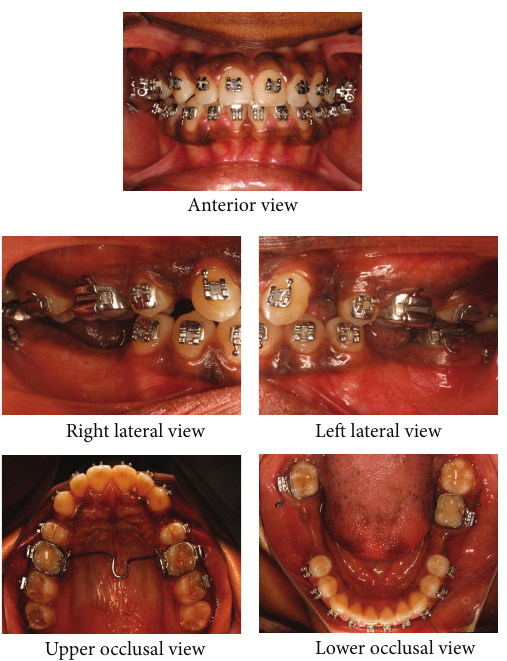
Figure 3: Mid-treatment intraoral photographs: alignment stage with microimplants for lower anterior retraction.